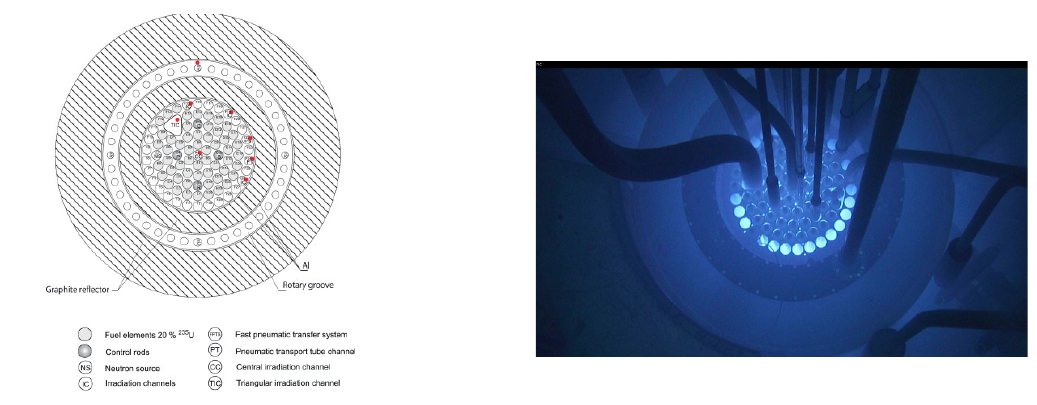
Fig. 4 : JSI TRIGA Mark II reactor core with typical fuel element configuration and irradiation positions.